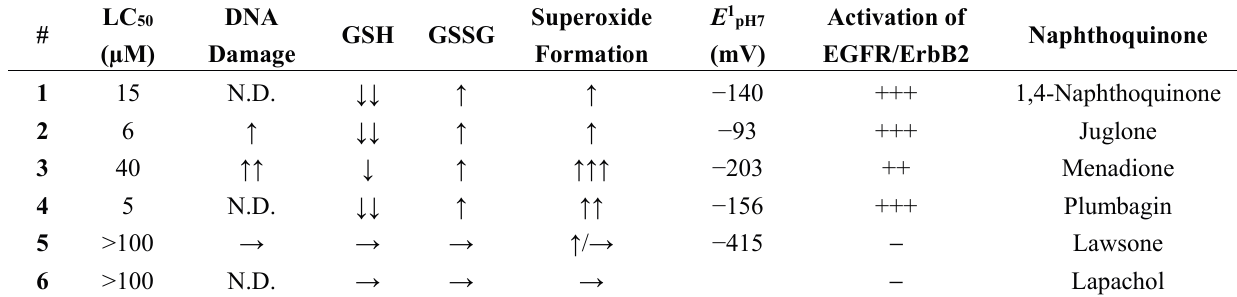
Table 2. Oxidative stress and EGFR/ErbB2 activation in HaCaT cells exposed